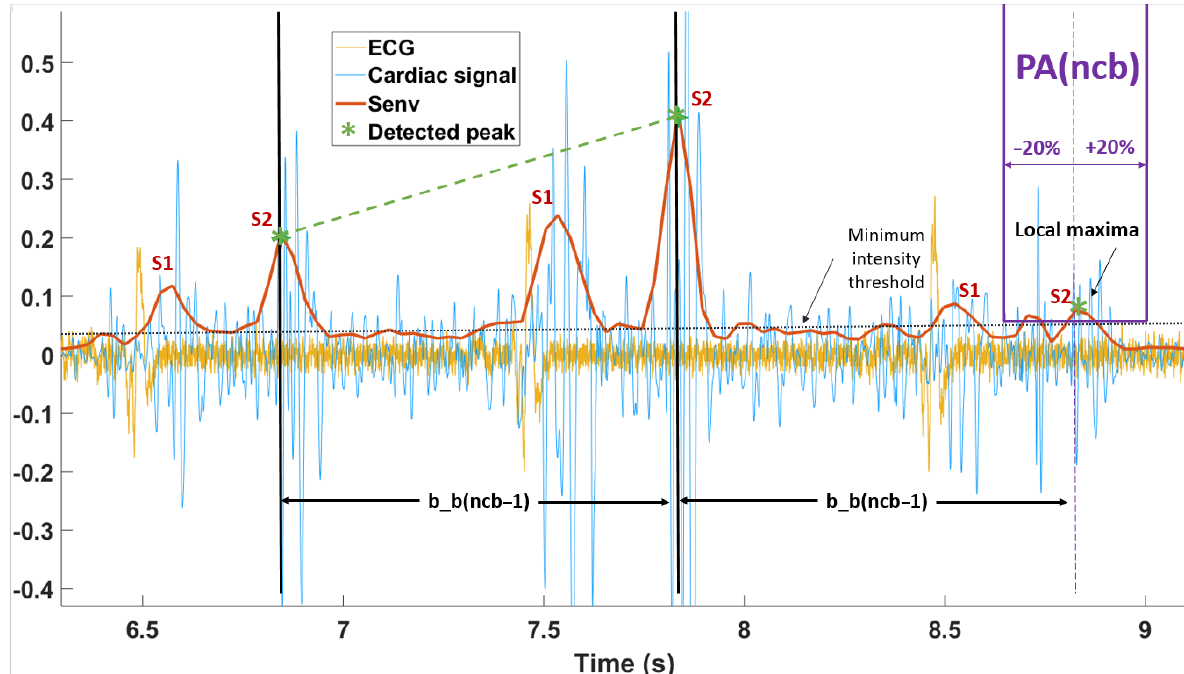
Figure 7. Cardiac S peak detection. There is a small delay between the electrocardiogram (ECG) ( yellow ) and the extracted cardiac signal ( blue ). Predicting area PA(ncb) (purple) defined by ± 20% of last heart beat-to-beat interval b _ b ( ncb − 1 ) and the adaptive threshold. The cardiac envelogram is in red, and the detected cardiac peak (S1/S2) is marked by a green star.